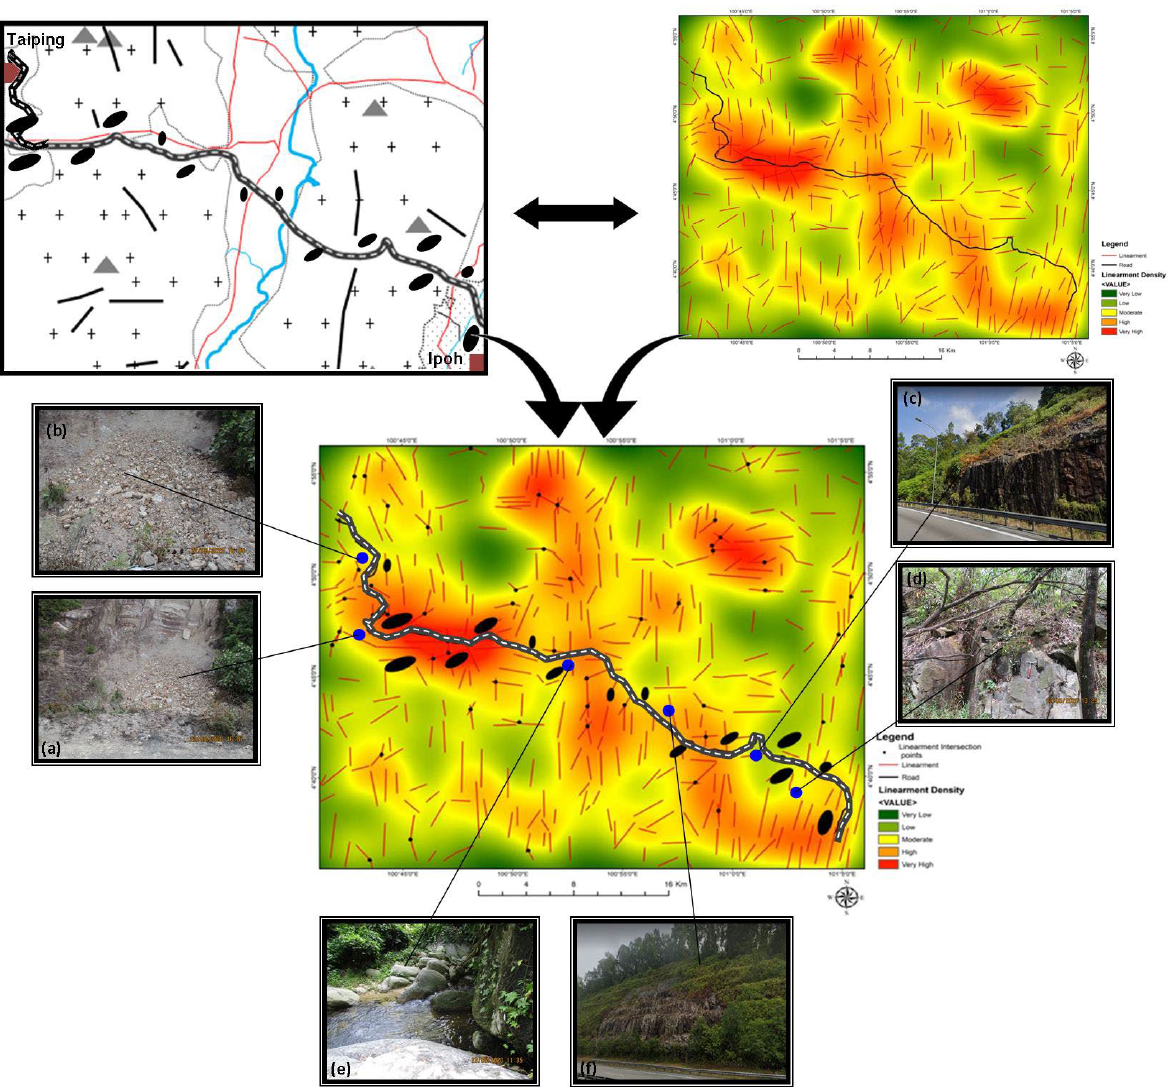
Figure 13: Superimposition of lineament thematic map over strain ellipsoid and orientation distribution map indicating landslide vulnerability with respective ground truthing conducted verifying each of the lineament density